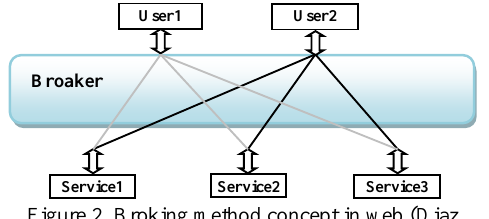
Figure 2. Broking method concept in web